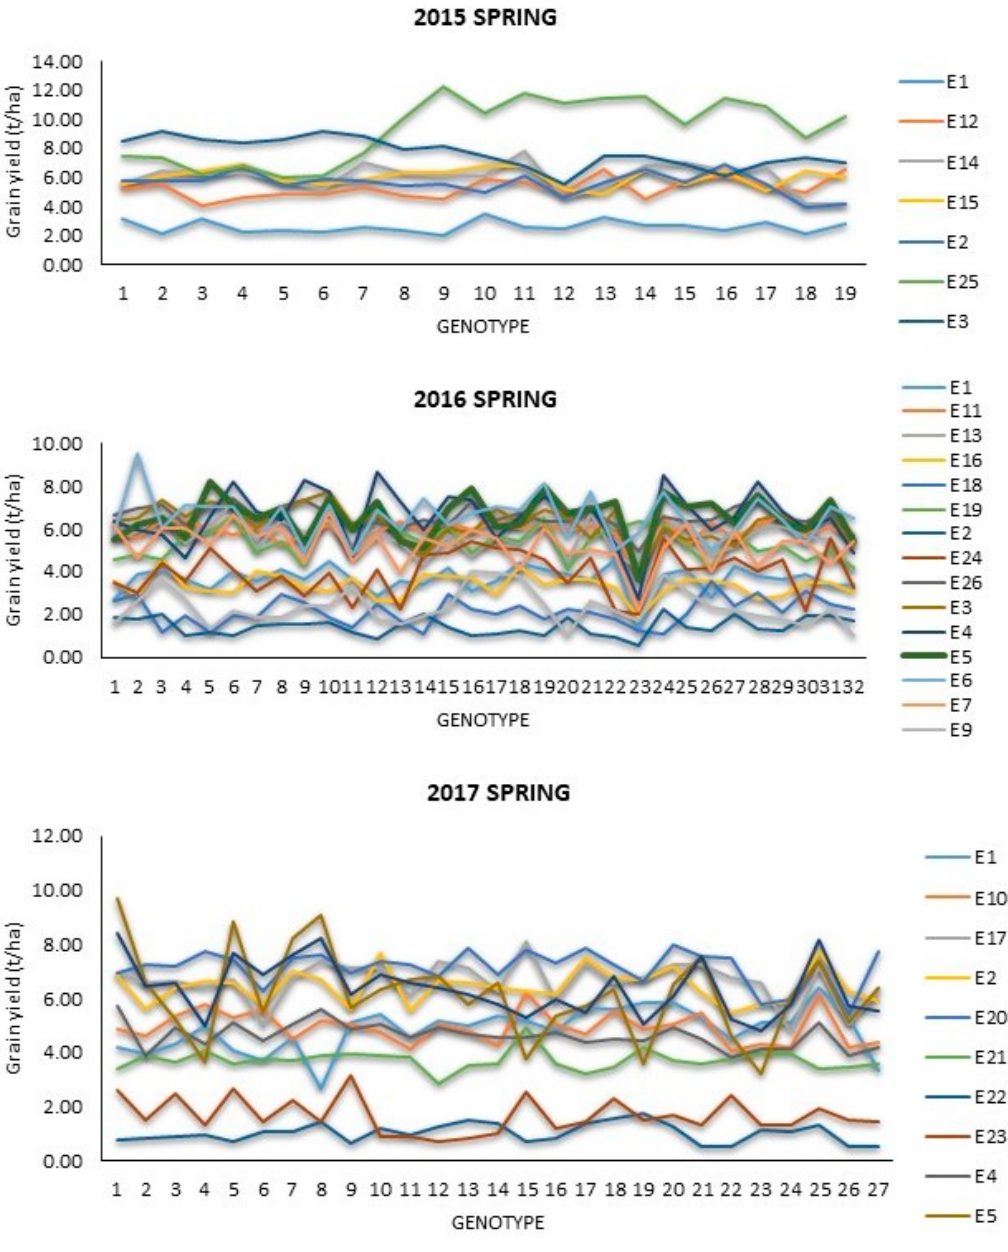
Figure 2. Performance of genotypes across different heat stress environments from 2015 to 2017. E1 to E27 are designated number of the locations in each season detailed in Table 1.